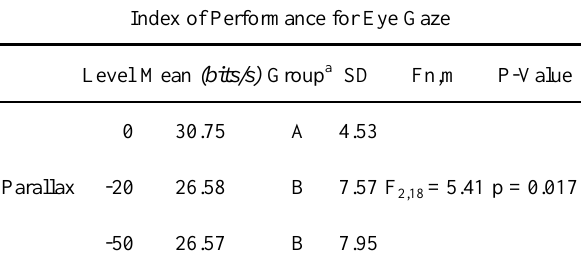
Means, SDs, ANOVA, and Tukey HSD test results of index of performance for eye gaze Index of Performance for Eye